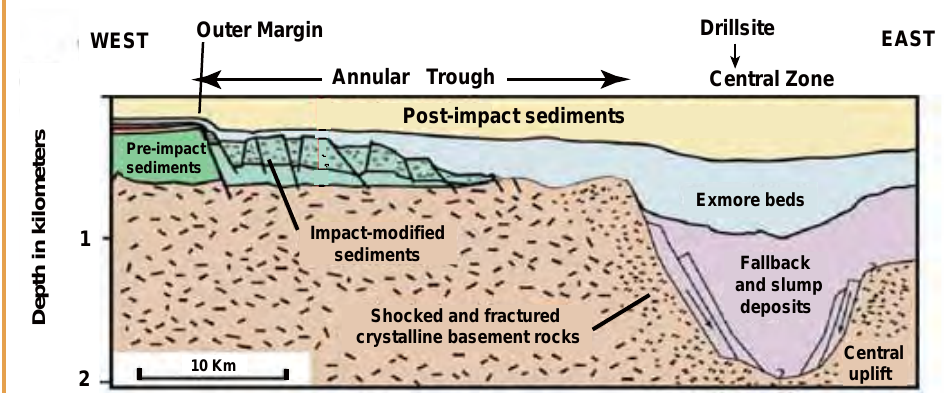
Figure 2. Schematic radial cross section showing half of “inverted sombrero” shape of Chesapeake Bay impact structure. Modifi ed from Horton et al.,